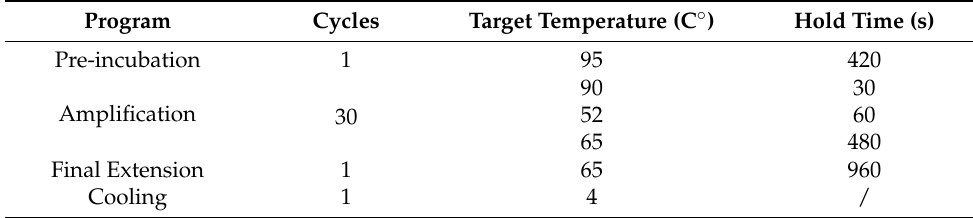
Table 5. ERIC-PCR protocol.